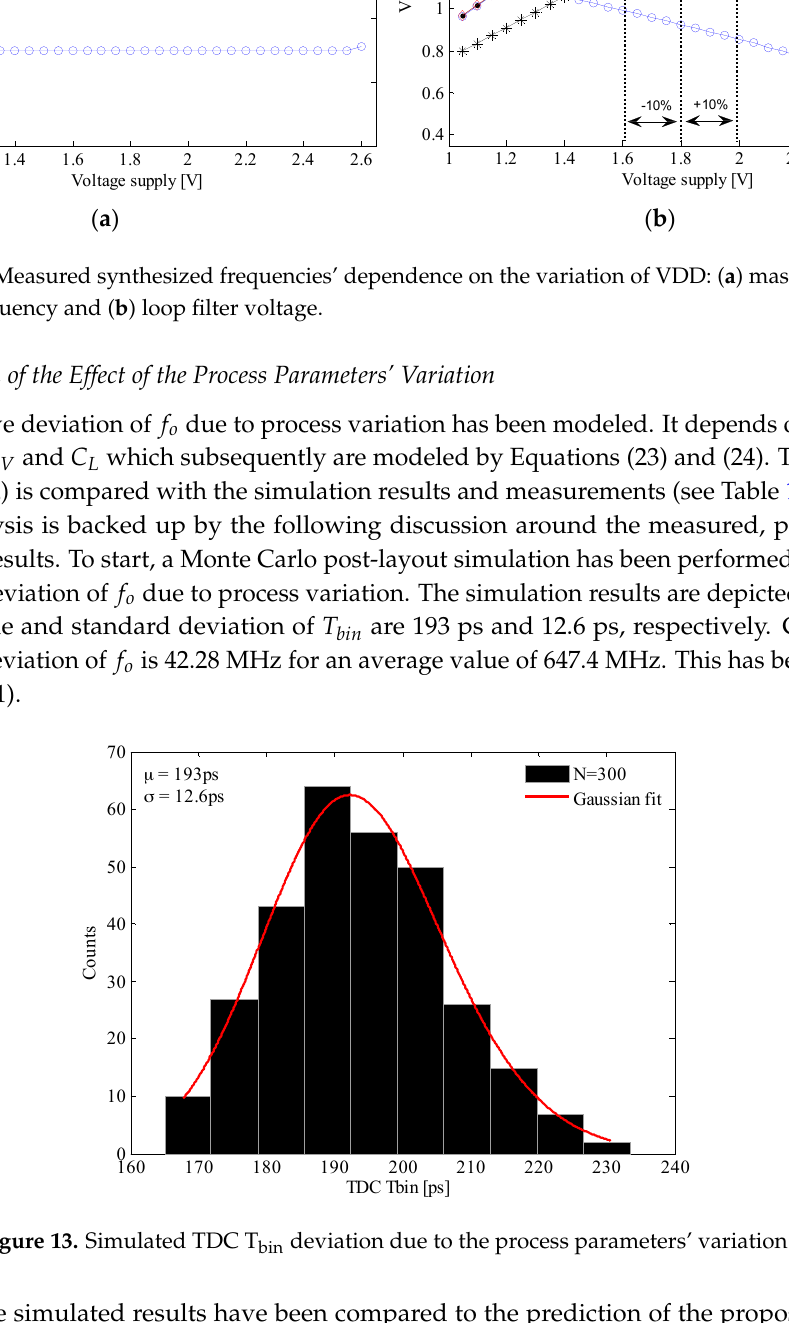
Table 1. Comparative results.